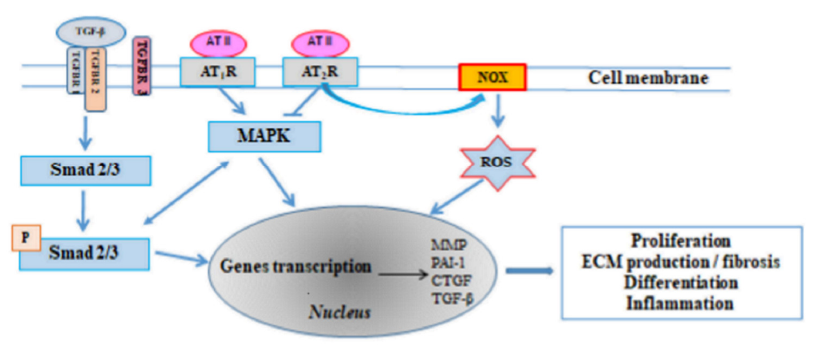
Figure 1. TGF-β signalling pathway and Ang II effects via AT 1 -R and AT 2 -R receptors. Ang